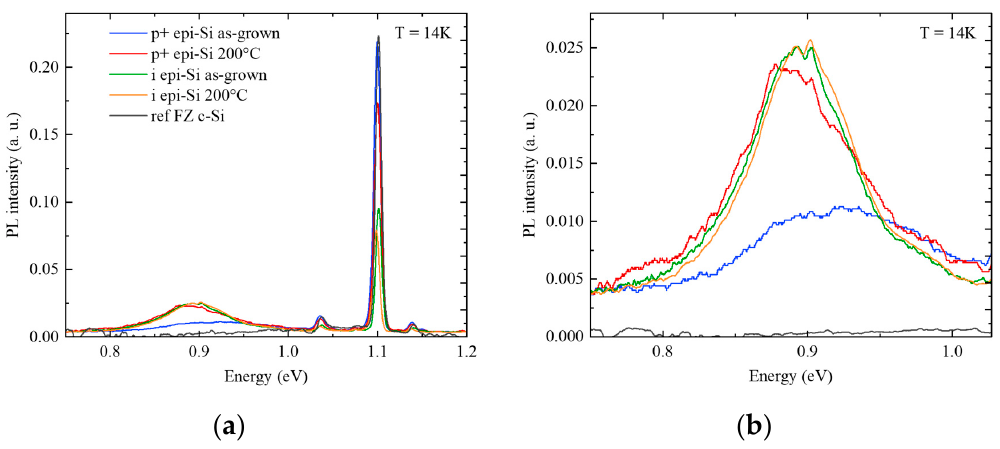
Figure 4. ( a ) PL at 14K before and after annealing p+ and intrinsic epi-Si layers. The spectrum of the c-Si substrate is added as a reference. ( b ) Zoom-in on the broad band at 0.9